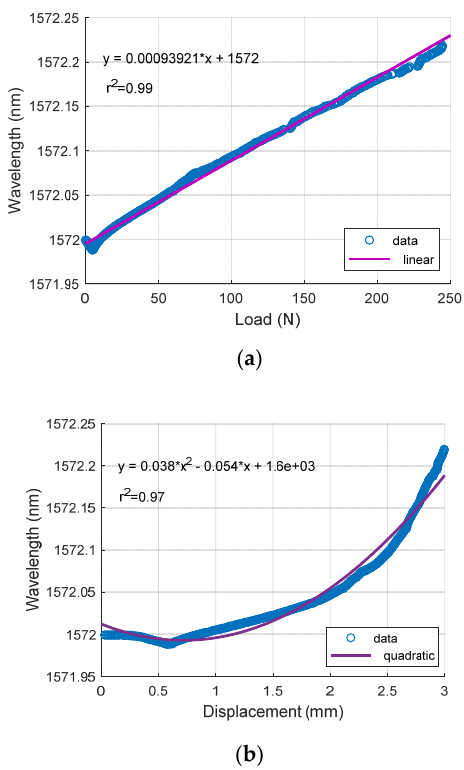
Figure 5. Compression test of the FBG sensor secured on the PDMS gel membrane using the mechanical tester. Linear fitting was used for wavelength vs. load ( a ) with coefficient of determination (R-Squared) of 0.99. Quadratic fitting was used for wavelength vs. displacement ( b ) with R-Squared of